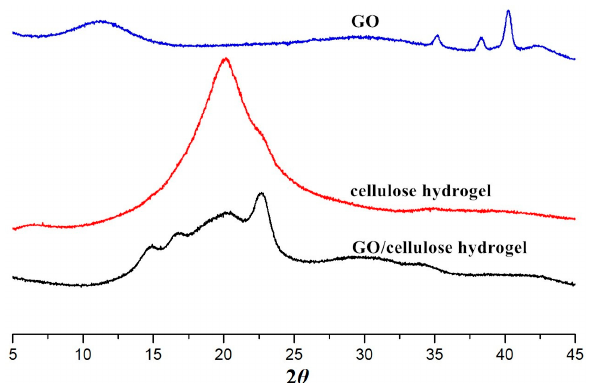
Figure 2. XRD patterns of GO, cellulose hydrogel, and GO(20)/cellulose(100) hydrogel.